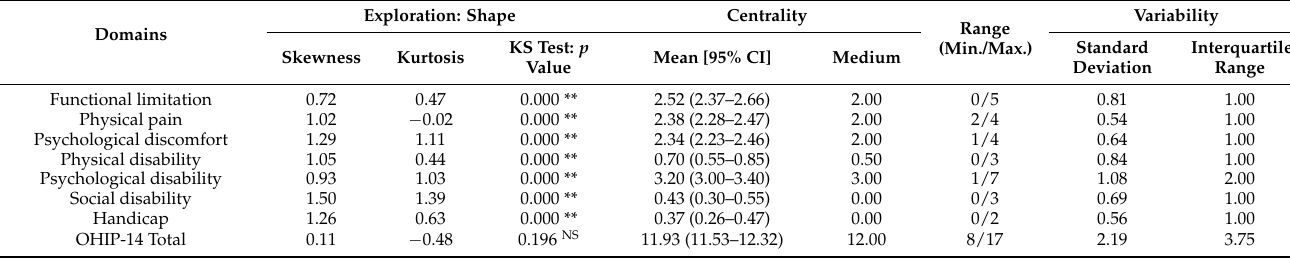
Table 2. Descriptive analysis. OHIP-14 questionnaire variables ( n = 120).